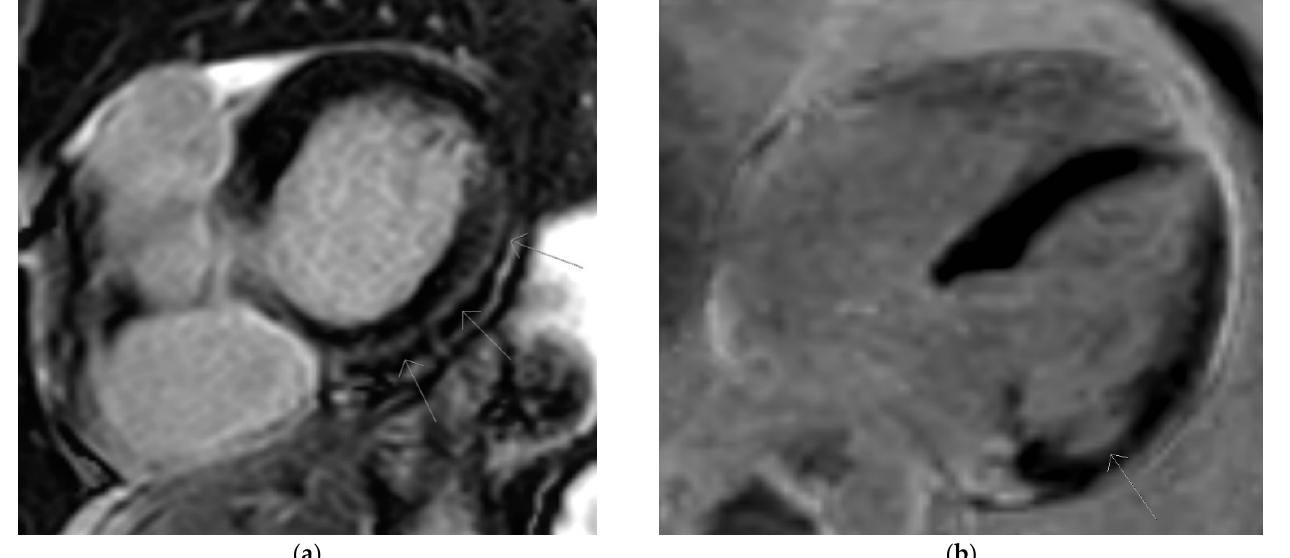
Figure 3. Cardiac magnetic resonance. ( a ) and ( b ) Late gadolinium enhancement (LGE) inferolateral basal midmyocardial and subepicardial (arrows) in two chamber and four chamber views.